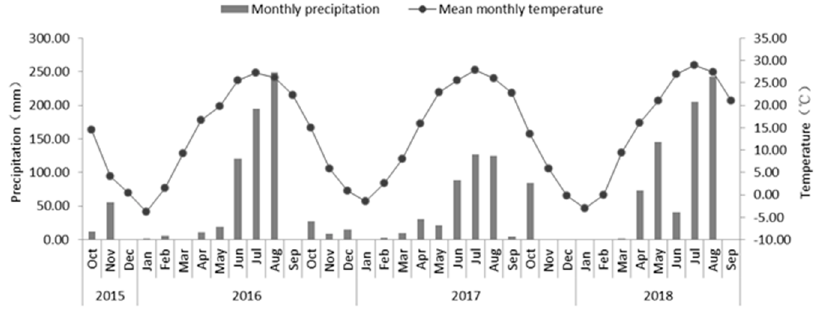
Figure 1. Average temperature and precipitation during the research period at Wuqiao Station, Hebei province, China.